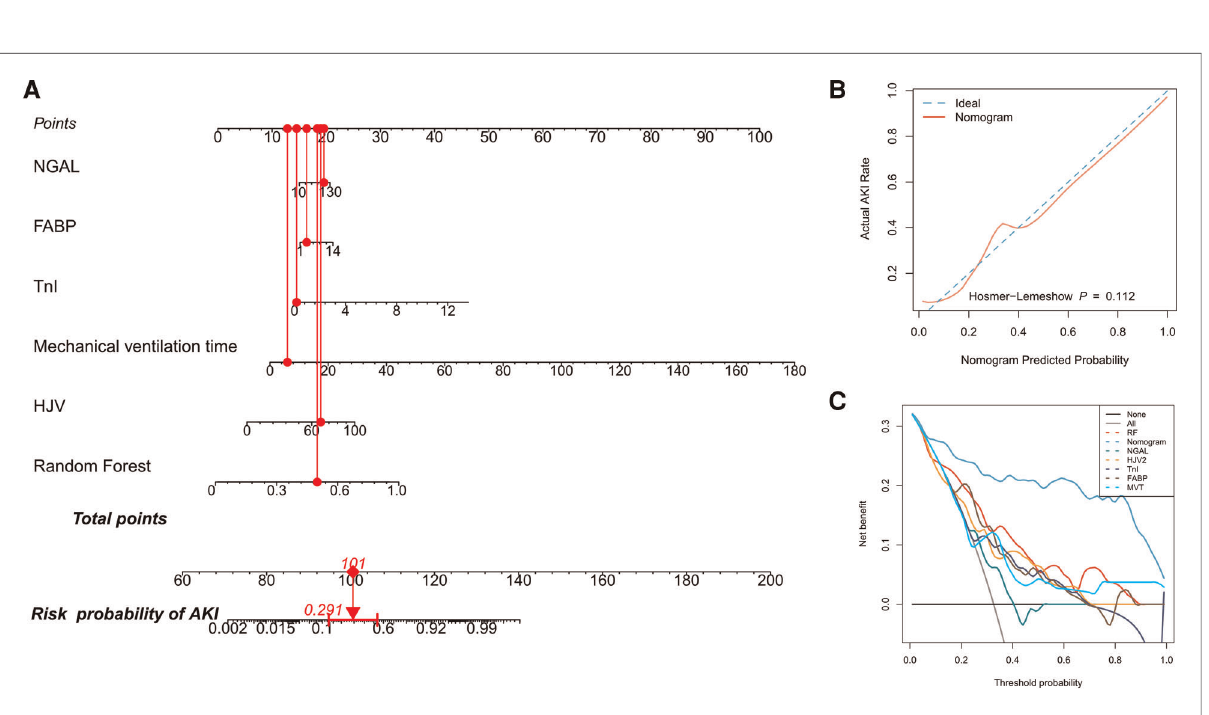
FIGURE 2 Quantifying patients ’ risk of CSA-AKI. ( A ) Nomogram used to quantify the risk of CSA-AKI in patients. Redline presents the detailed score of a certain patient, with a total of 101 points and a 29.1% risk of developing CSA-AKI; ( B ) calibration curve for the nomogram; ( C ) DCA curves for performance comparisons between clinical characteristics alone, the RF model, and the nomogram by plotting the net bene fi t of the prediction model and clinical predictors against the threshold probabilities, wherein the horizontal axis represents the threshold (the reference probability of the patient receiving treatment) and the vertical axis represents the net bene fi t rate after subtracting the disadvantage from the advantage. Using the model, under the same threshold probability, a larger net bene fi t indicates that the patient can obtain the greatest bene fi t. DCA: decision curve